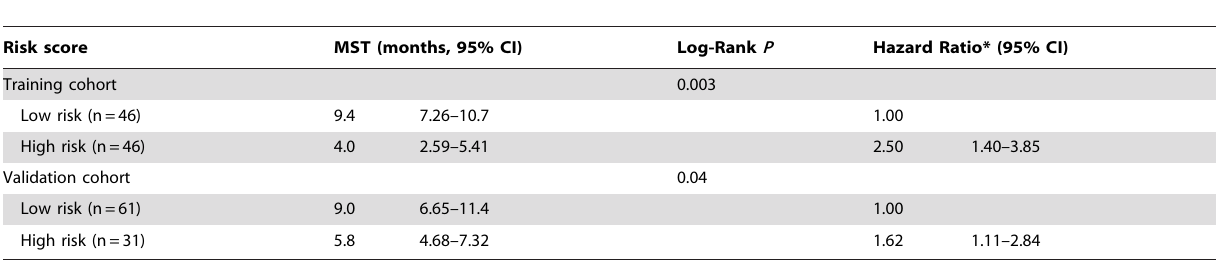
Table 4. Risk score and patient survival for training and validation cohort.